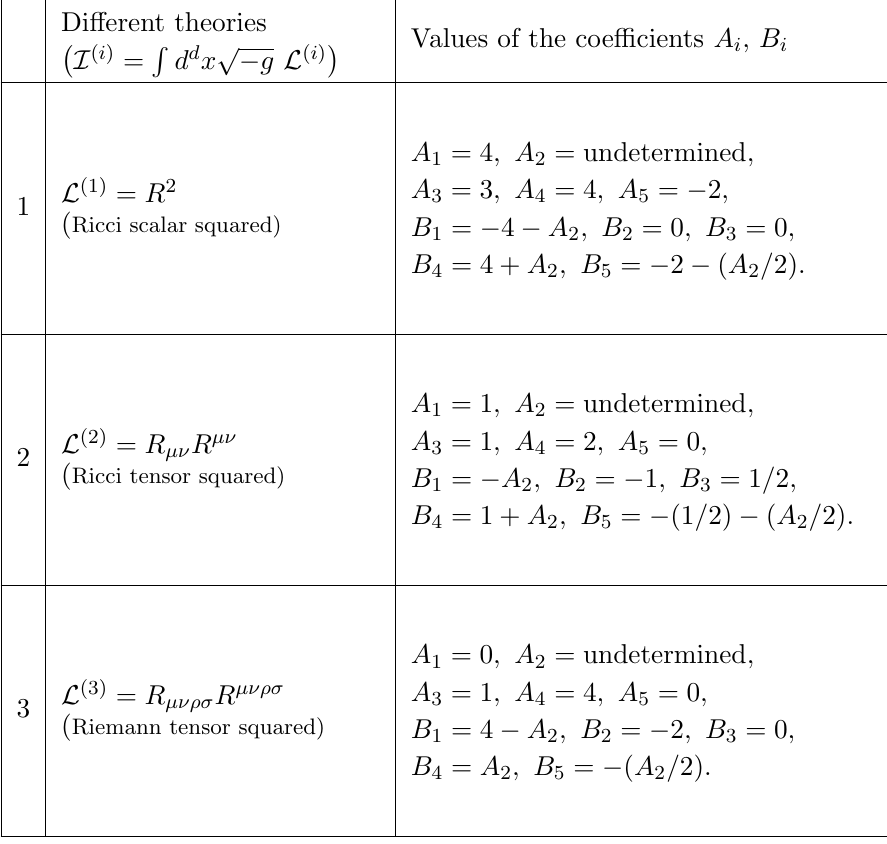
Table 11 . A i ; B i ’s for di(cid:11)erent 4-derivative theories of